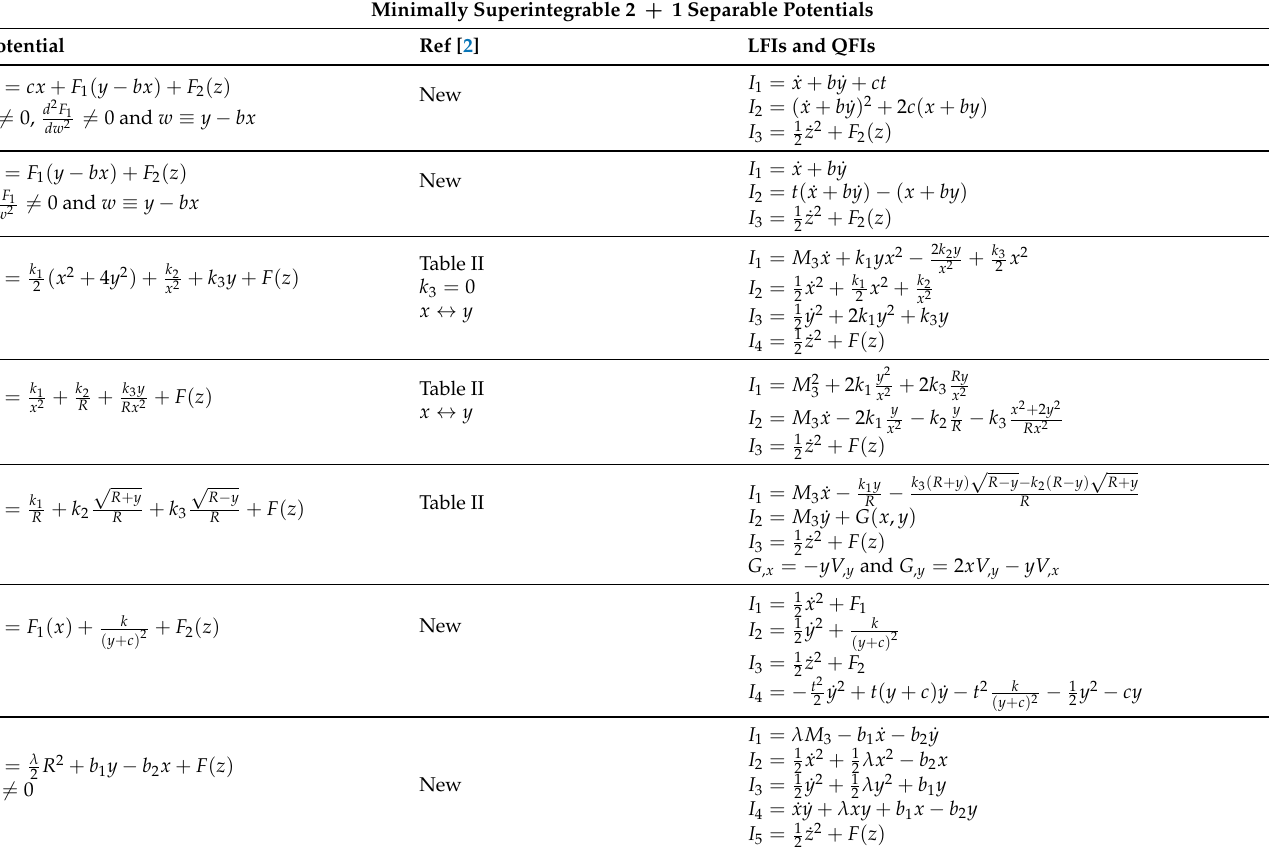
Table 2. Minimally superintegrable potentials V ( x , y , z ) = Φ ( x , y ) + F ( z ) in E 3 , where Φ ( x , y ) are superintegrable potentials in E 2 .